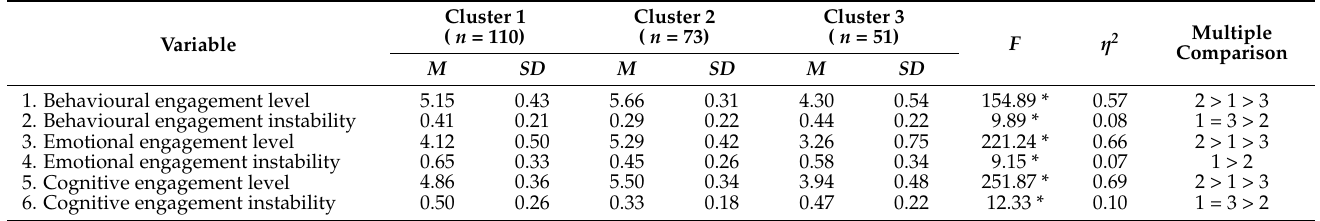
Figure 2. Within sum of squares by number of clusters. Table 6. The differences in learning engagement between different clusters and the results of multiple comparisons by using the Holm test.